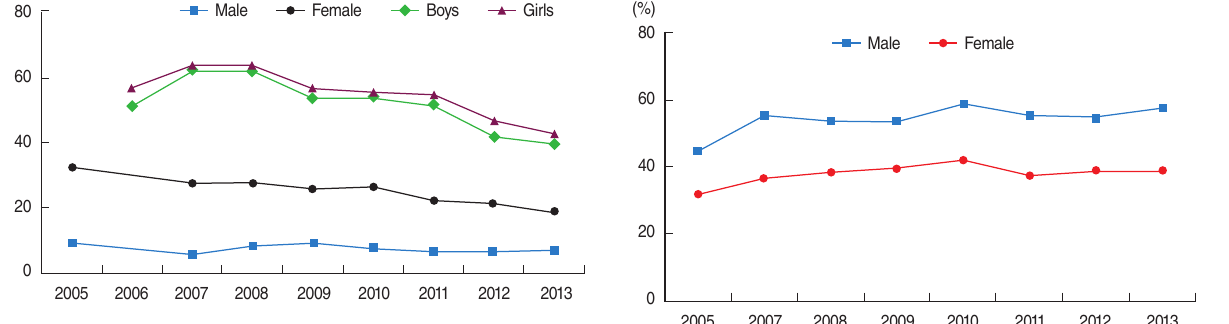
Table 1. Prevalence of current cigarette smoking 1 among adults in the Korea National Health and Nutrition Examination Survey, 2013